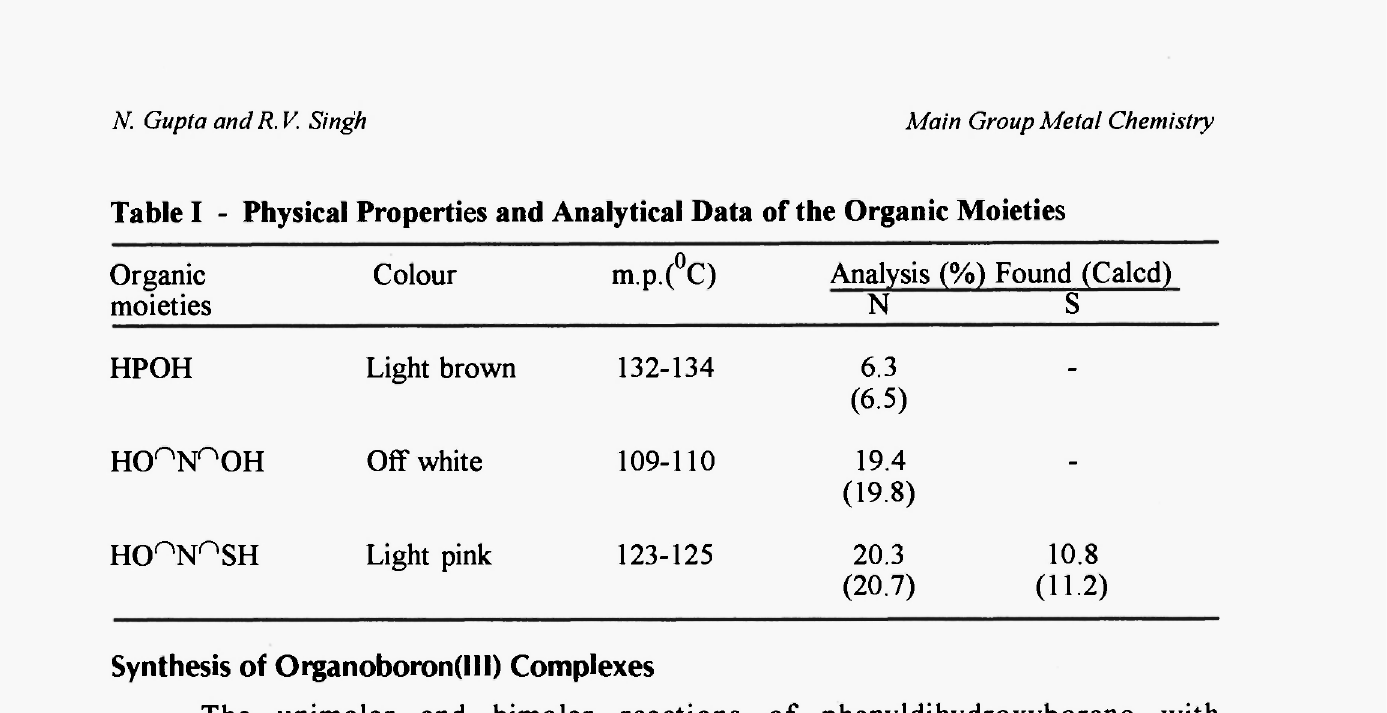
Table I - Physical Properties and Analytical Data of the Organic Moieties Organic